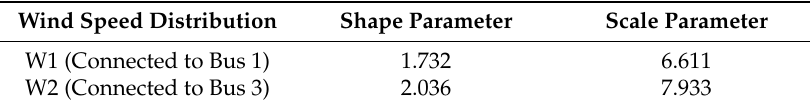
Table 2. Parameters of Weibull distributions (modified IEEE 9-bus test